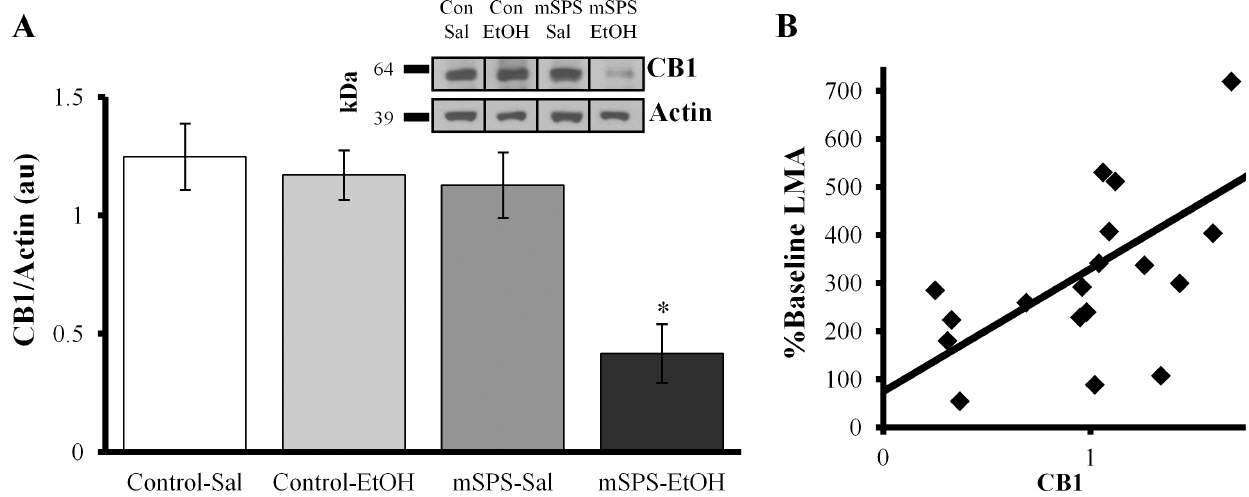
Fig 5. CB1 receptor protein was significantly decreased in mice exposed to mSPS followed by chronic EtOH in the anterior striatum compared to all other treatments. (A) * p < 0.05; au, arbitrary units. Representative samples inserted in upper right corner (kDa, kilodaltons). (B) LMA movements at challenge compared to LMA during last 10 min of habituation (% Baseline) positively correlated with striatal CB1 receptor protein ( p < 0.05), suggesting that LMA decreased as CB1 receptors decreased. doi:10.1371/journal.pone.0155759.g005 PLOS ONE | DOI:10.1371/journal.pone.0155759 May 17,